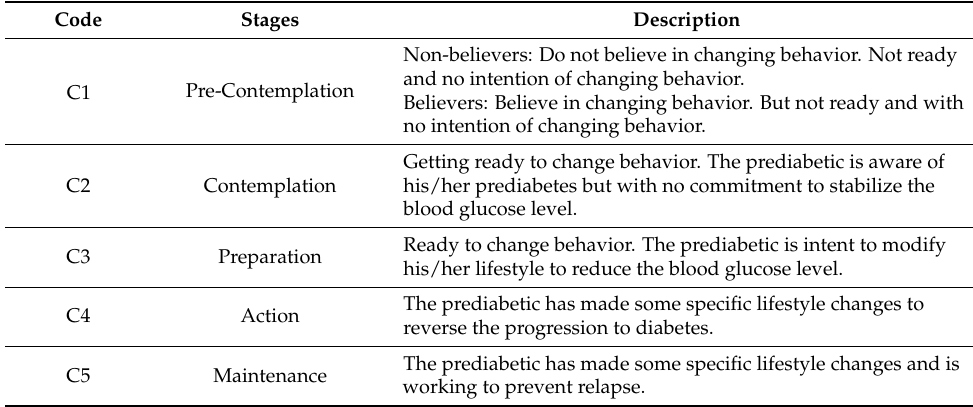
Figure 1. Conceptual framework for prediabetes self-care systems. Table 1. The stages of change.